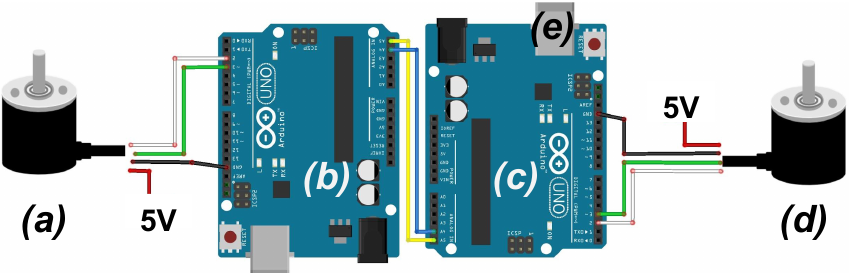
Figure 14. The wiring diagram for motor encoders. ( a ) The driving motor encoder. ( b ) The I2C master. ( c ) The I2C slave is connected to the main laptop computer. The motor controllers are connected to this microcontroller. ( d ) The steering motor encoder. ( e ) The USB connector communicates with the laptop